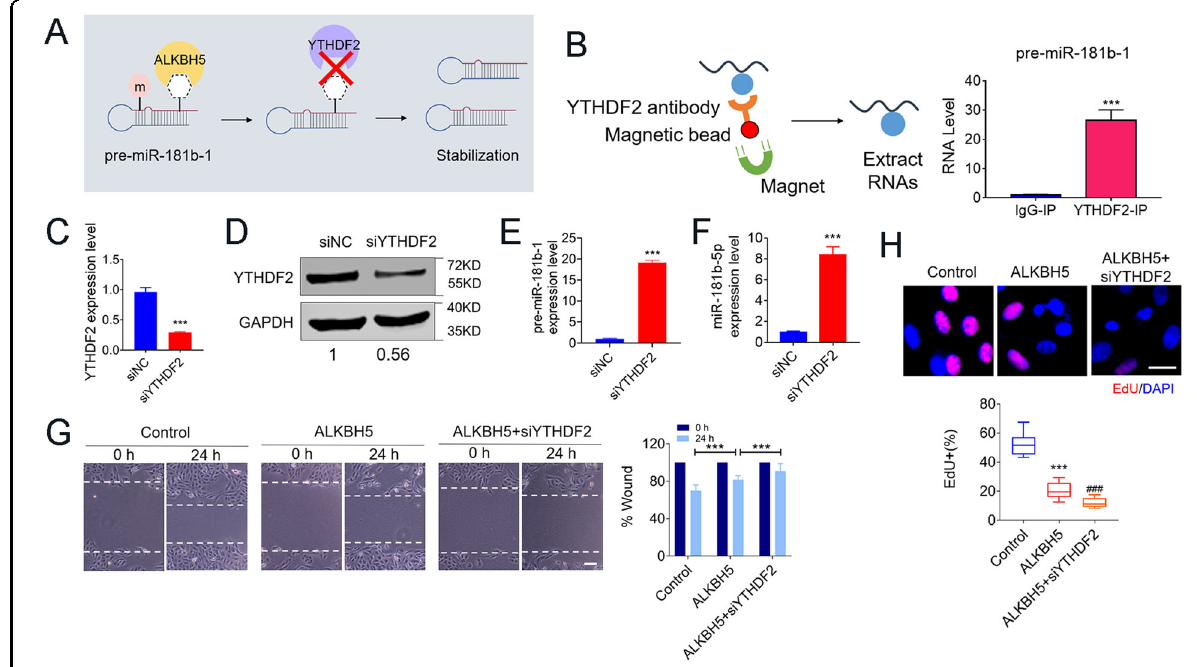
Fig. 6 m 6 A reader YTHDF2 positively regulates pre-miR-181b-1 stabilization. A Schematic diagram displaying that YTHDF2 promotes pre-miR- 181b-1 stabilization via competing with ALKBH5 for pre-miR-181b-1 combining. B RIP assay showing that the anti-YTHDF2 antibody ef fi ciently captured miR-181-5p transcripts. C , D Transfection ef fi ciency of YTHDF2 silencing con fi rmed via qRT-PCR and western blot. E , F Inhibition effects of siYTHDF2 both on pre-miR-181b-1 ( E ) and miR-181-5p expression ( F ). G , H Migration ( G , Bar: 200 μ m, n = 4) and proliferative abilities ( H , Bar: 25 μ m, n = 5) of U2OS after transfected with ALKBH5 plasmids and/or co-transfected with siYTHDF2. Data are expressed as mean ± SEM. *** P < 0.001 (vs. the fi rst group). ### P < 0.001 (vs. the second